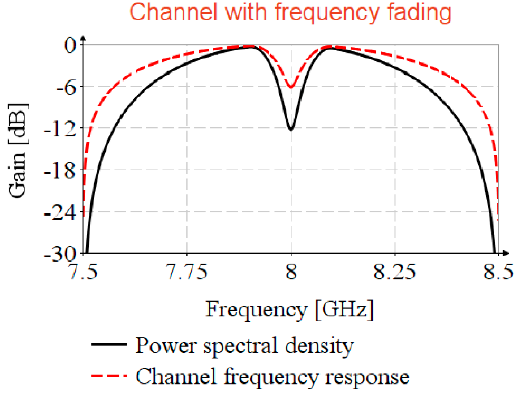
Figure 8. Psd mask and channel response. Algorithm 3 : Timestamp estimation in channel with frequency selective fading